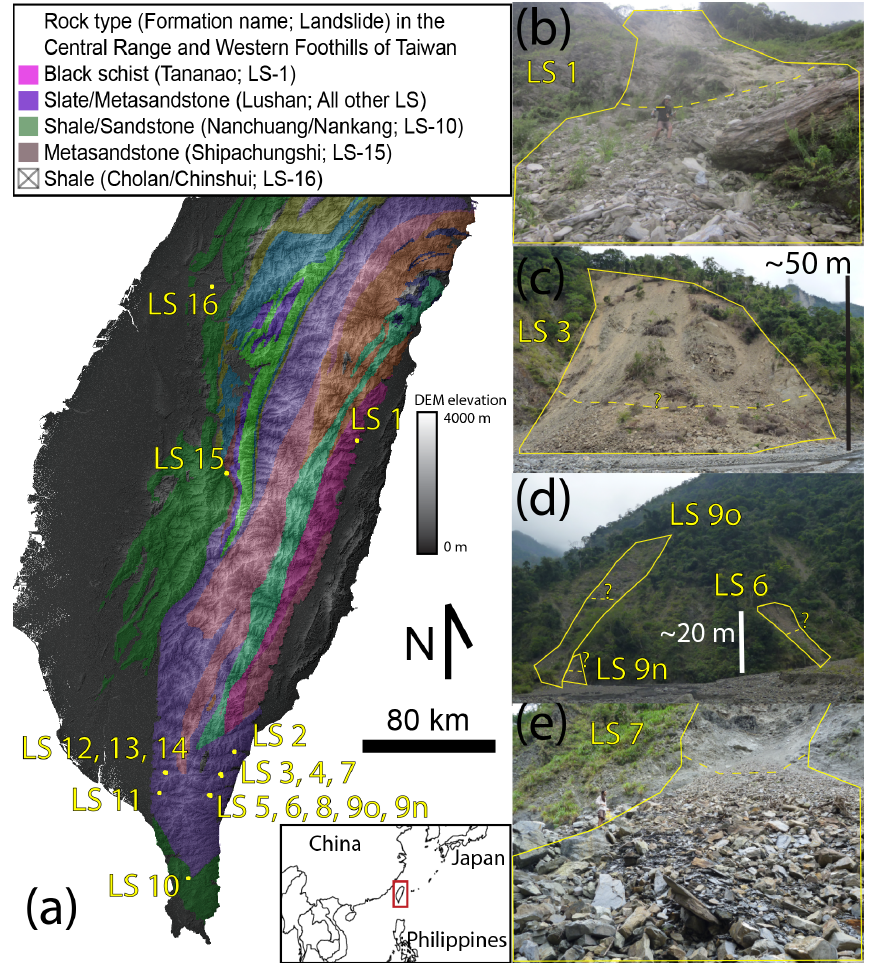
Figure 1. (a) Hill-shaded elevation map of Taiwan, showing the main lithological units of the Central Range (based on the geological map of Taiwan available from the Taiwan Central Geological Survey) and the locations of the 17 sampled landslides deposits. (b–e) Pictures of some sampled landslides, where the yellow line is the approximate contour of the landslide (sometimes going beyond the pictures), and the dashed line indicates the transition from deposit to scar (it is only tentative when associated with “?”). In panels (b) and (e) , the lead author is standing on the deposit for